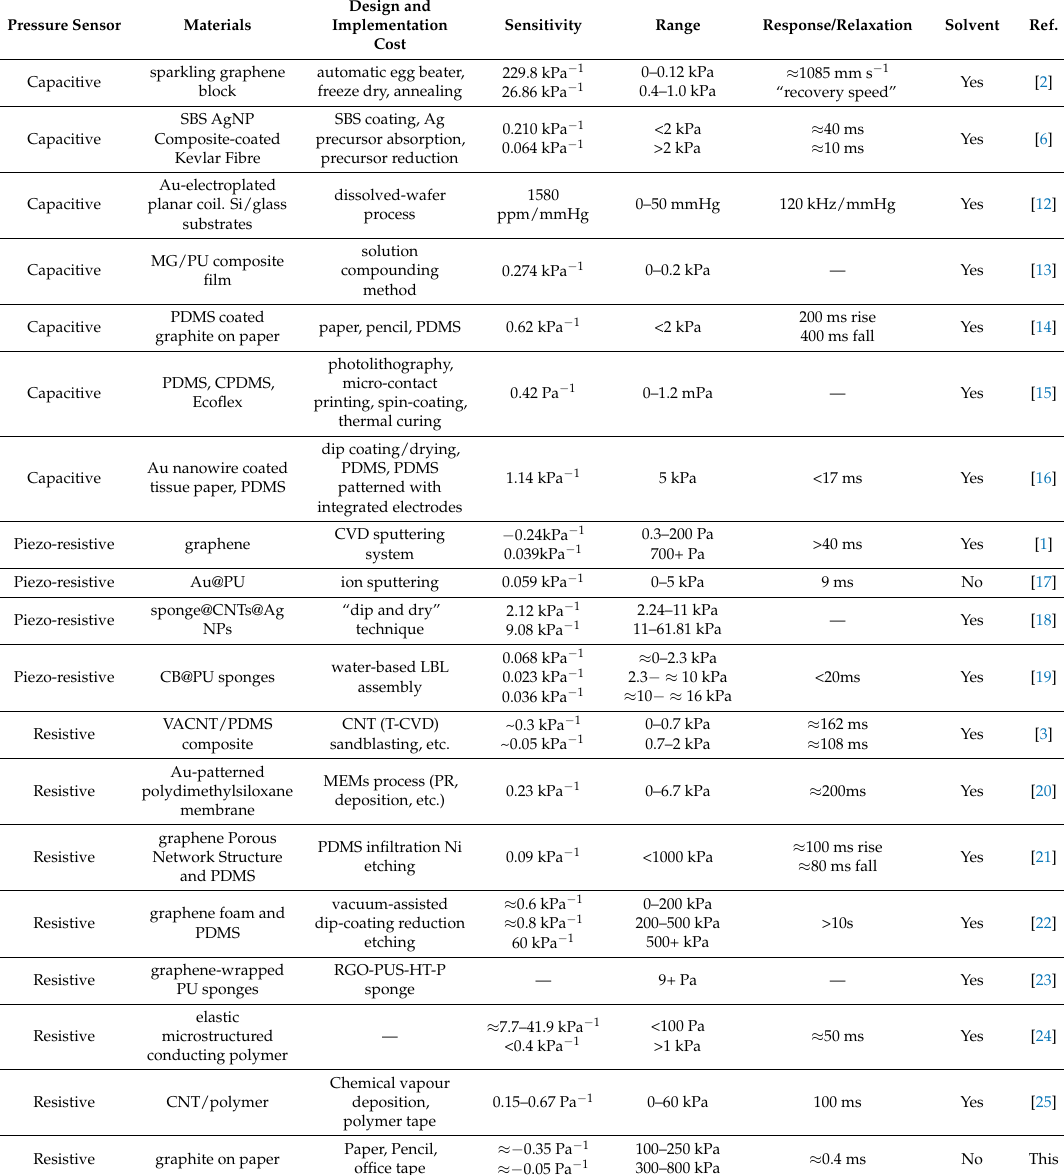
Table 1. Performance of pressure sensors in